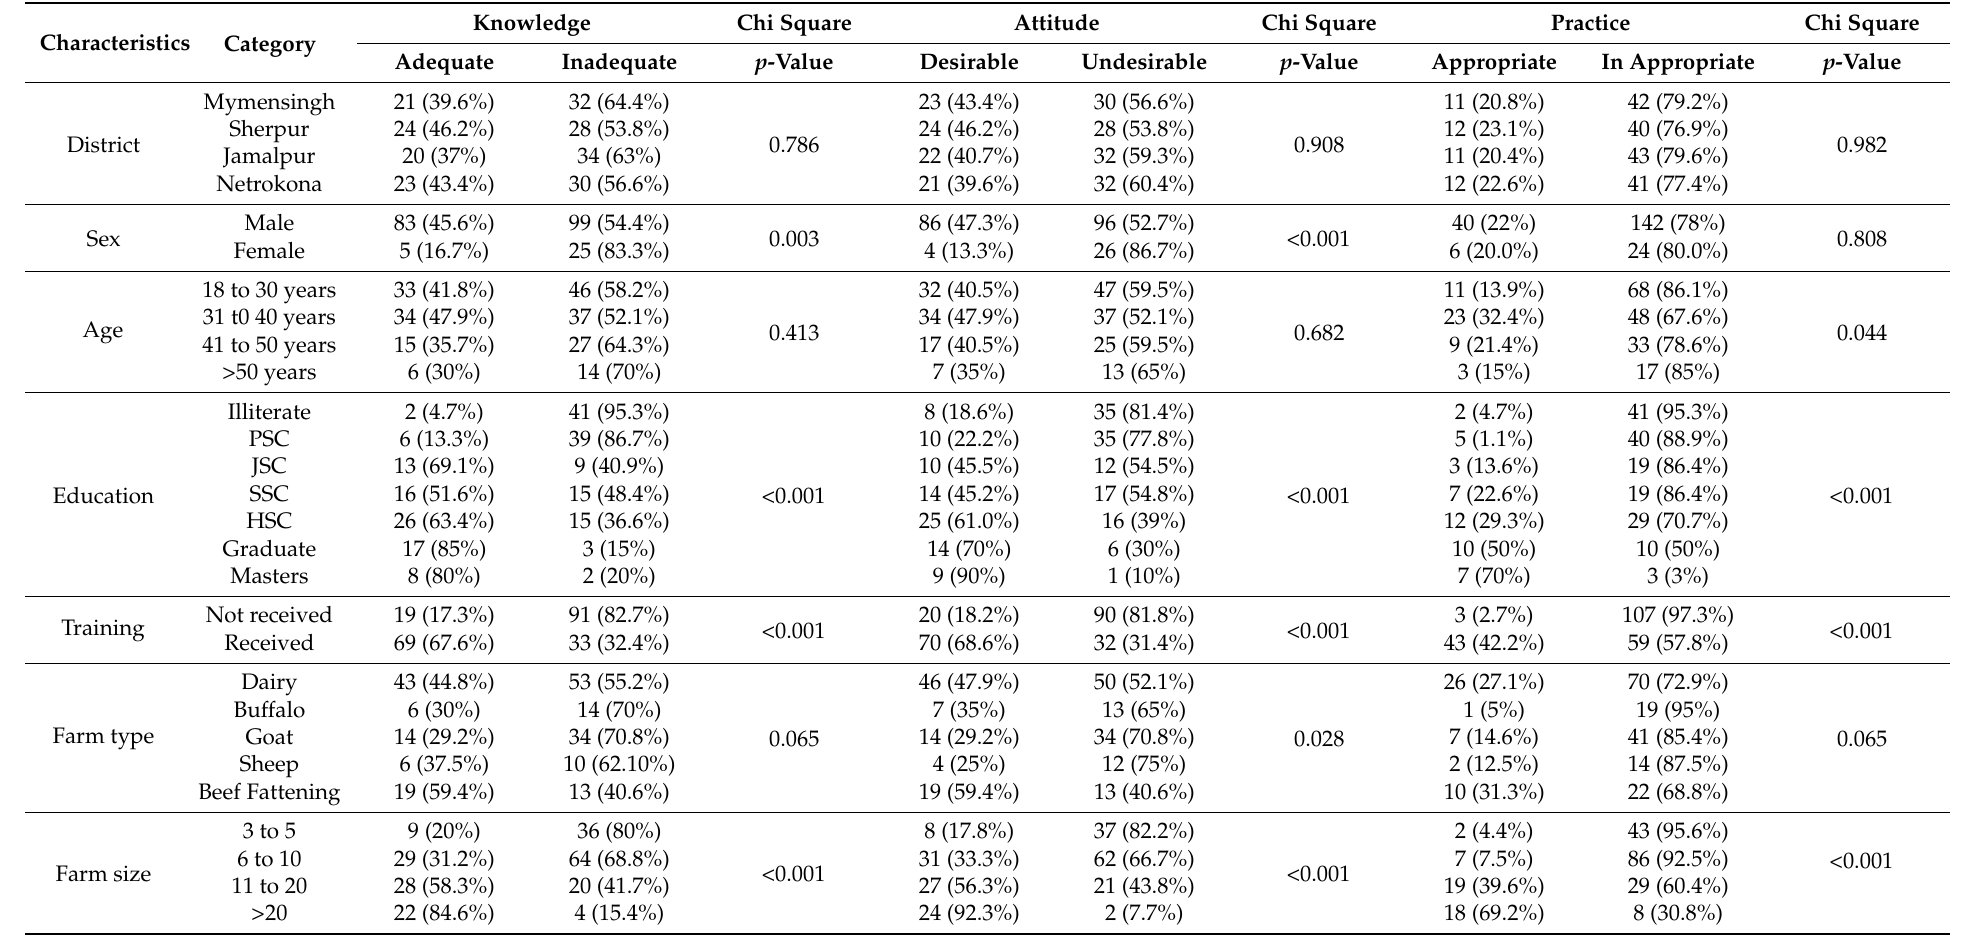
Table 2. Test of statistical significance of variation in the respondents’ knowledge on AMU and AMR by their